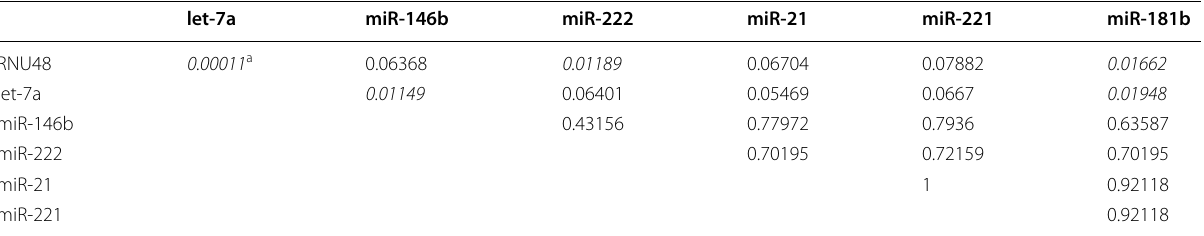
Table 1 P-values from the test whether miR-146b, miR-222, miR-21, miR-221, miR-181b and control RNU48, let-7a regression line slope coefficients are same or significantly